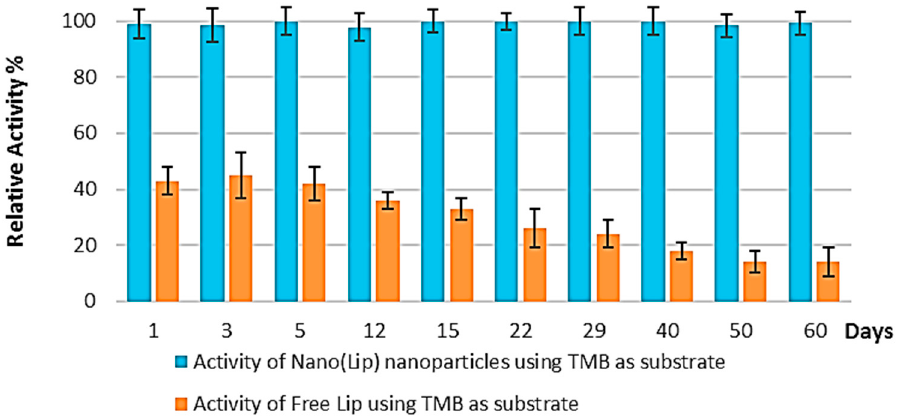
Figure 8. Linearity of free LiP and Nano-LiP.